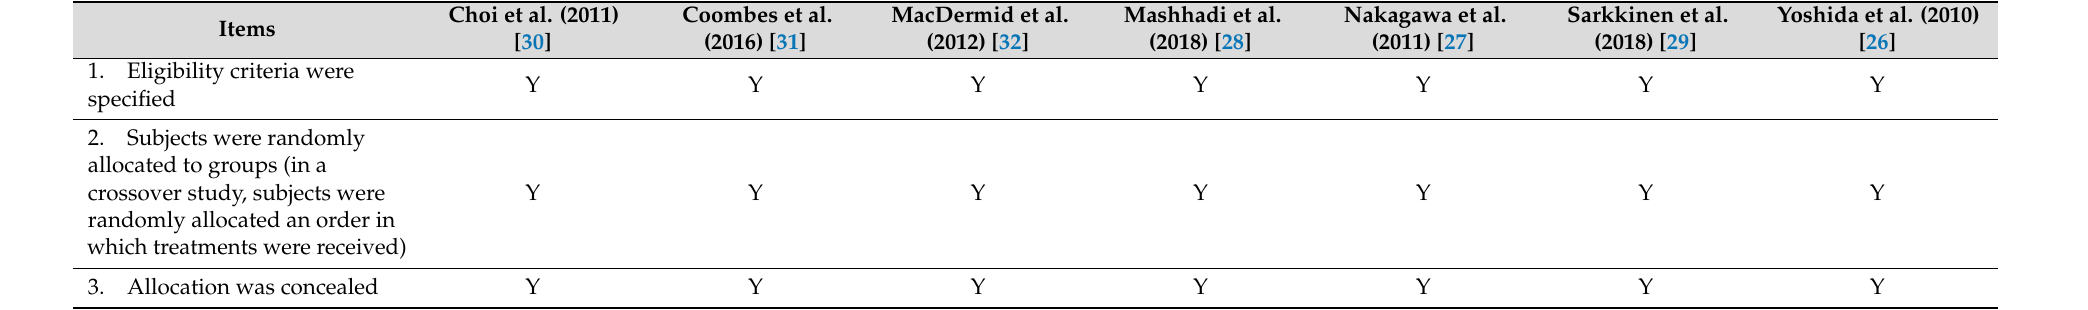
Table 3. Results of PEDro Scale ( n =